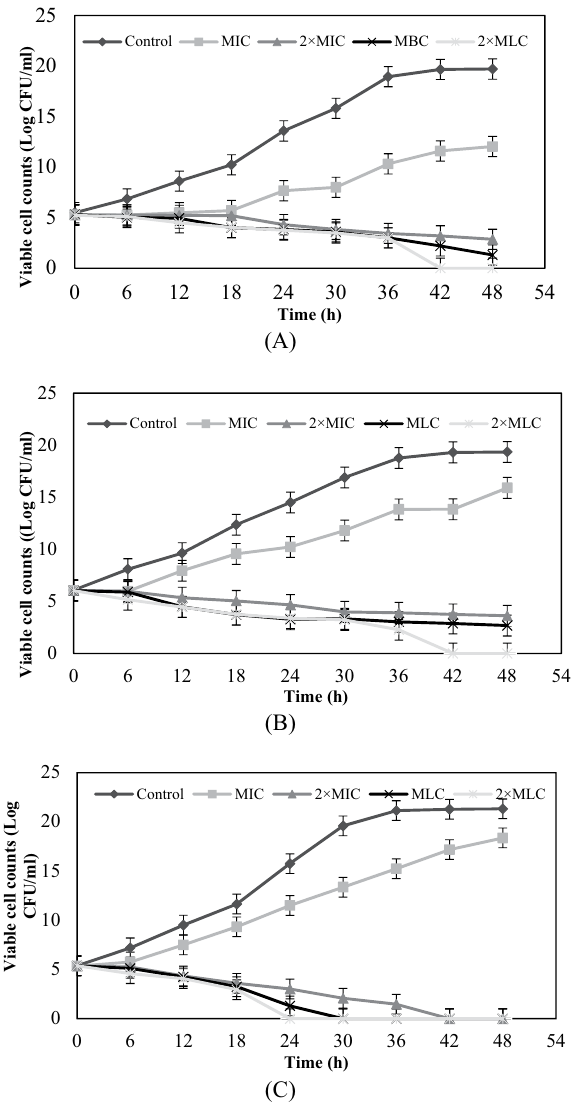
Figure 7. Growth curves of ( A ) S. aureus , ( B ) P . aeruginosa and ( C ) C. utilis exposed to four different concentrations of EoNP for a duration of 48